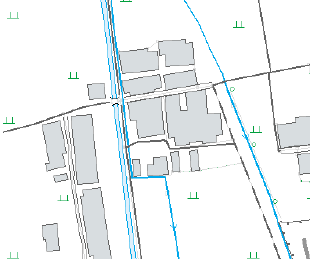
Figure 3. The map symbol described by PostScript